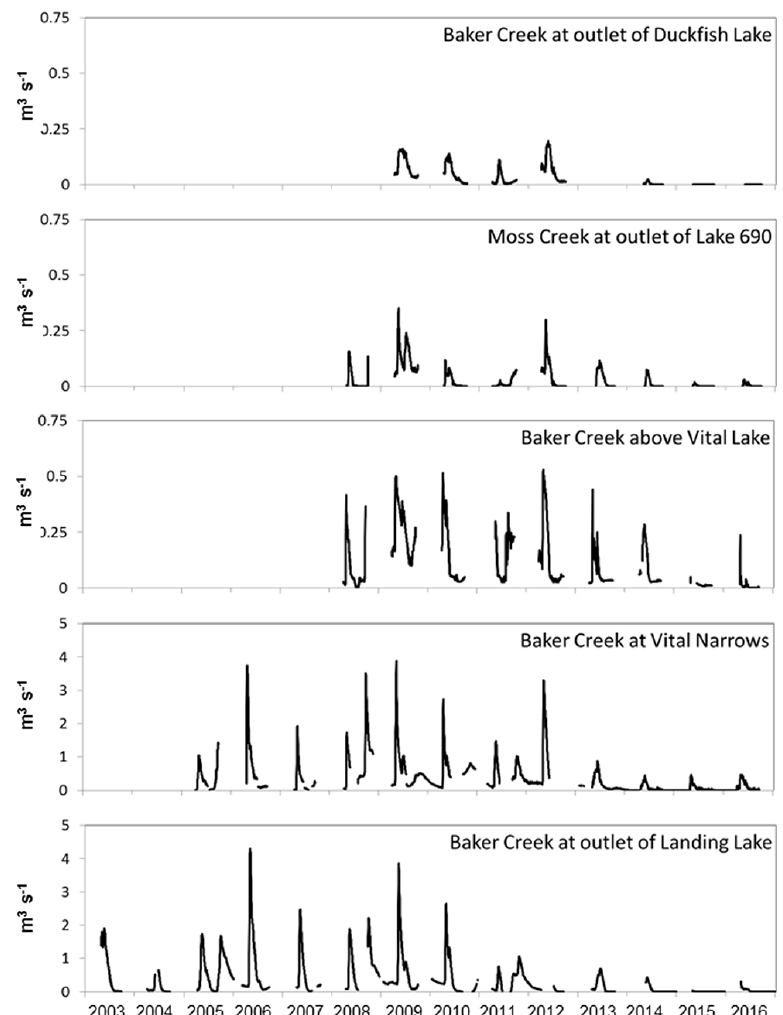
Figure 11. Daily streamflow (2003–2016) from the series of nested hydrometric gauges within the Baker Creek Research